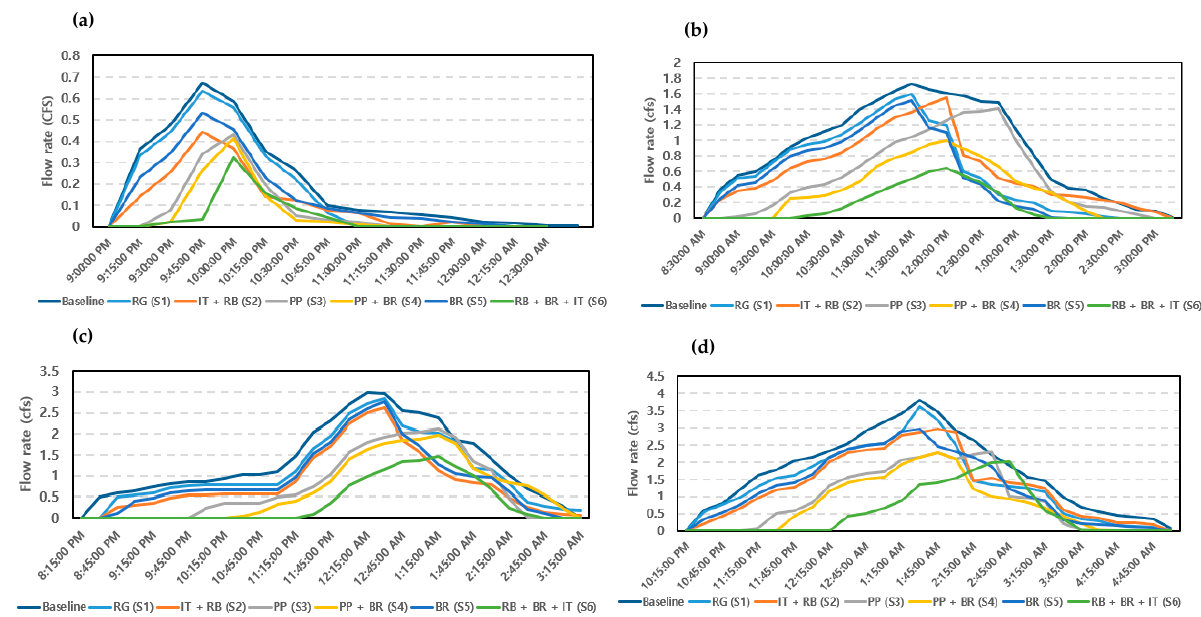
Figure 6. Hydrographs for the implementation of LID practices scenarios for ( a ) HIST 50, ( b ) HIST 100, ( c ) CC 50, and ( d ) CC 100 .